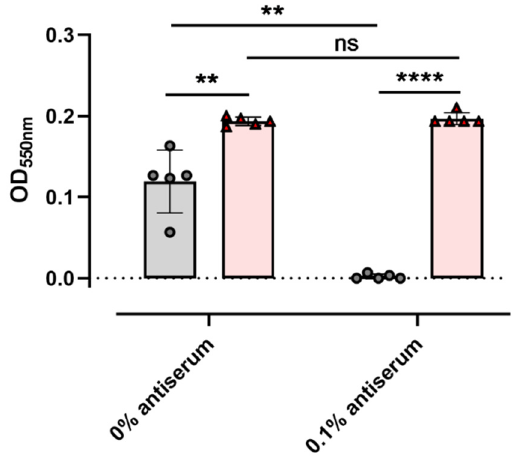
Figure 5. Haemolysis induced by a selection of NetB-positive (red) and NetB-negative (grey) strains, incubated with and without antiserum directed towards C. perfringens alpha toxin and perfringolysin O. Haemolysis is observed by an increase in optical density due to the release of haemoglobin from the red blood cells. Individual dots represent individual strains. ** p < 0.01, **** p < 0.0001, ns = not significant ( p > 0.05).